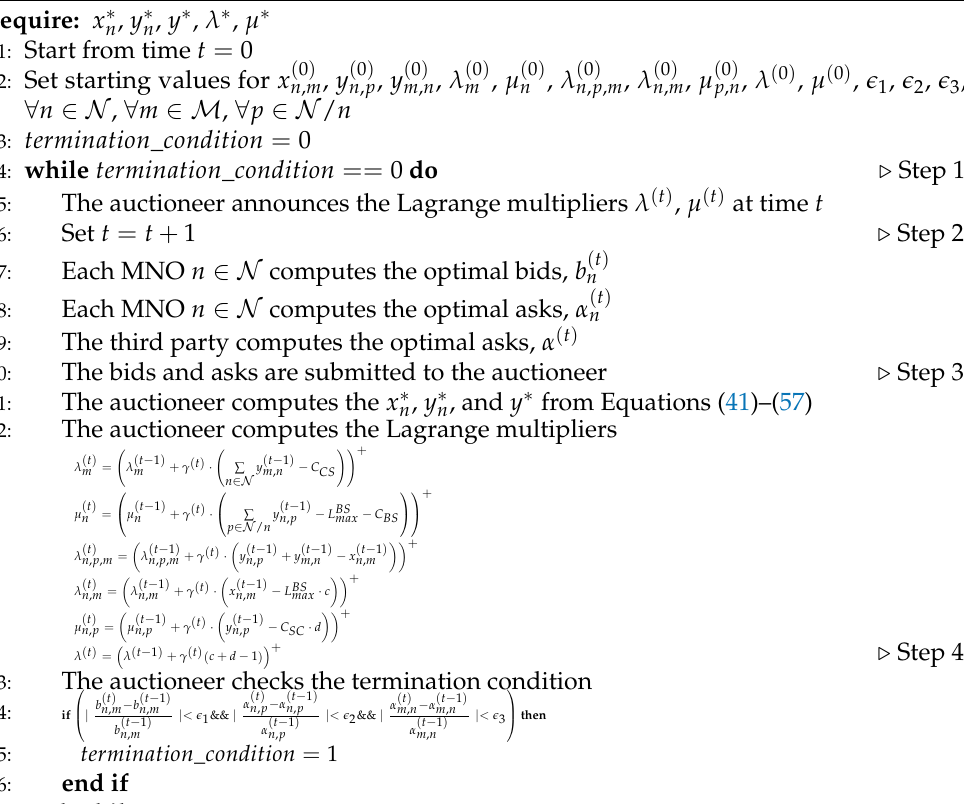
Algorithm 1 Energy Minimization Iterative Offloading (EMIO)